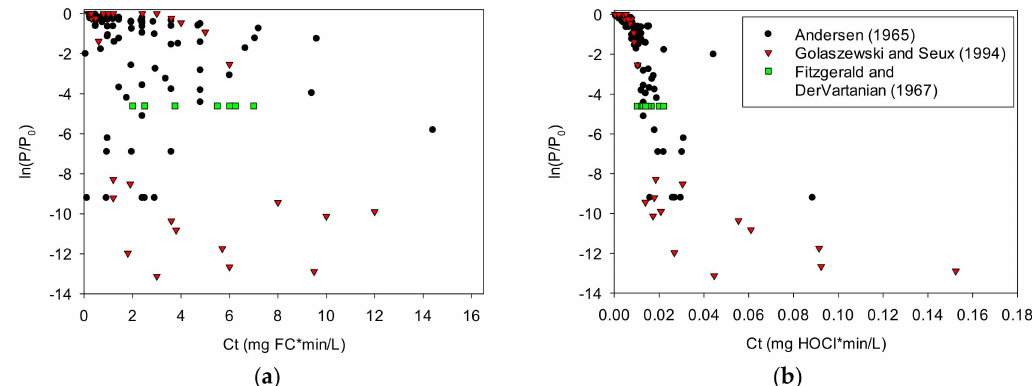
Figure 3. Relationship between log reduction, ln(P / P 0 ), and Ct for Streptococcus faecalis , where C represents the concentration of ( a ) free chlorine or ( b ) hypochlorous acid: The HOCl concentrations werecalculated using values for freechlorine, pH, CYA, and temperaturefrom the source data references.